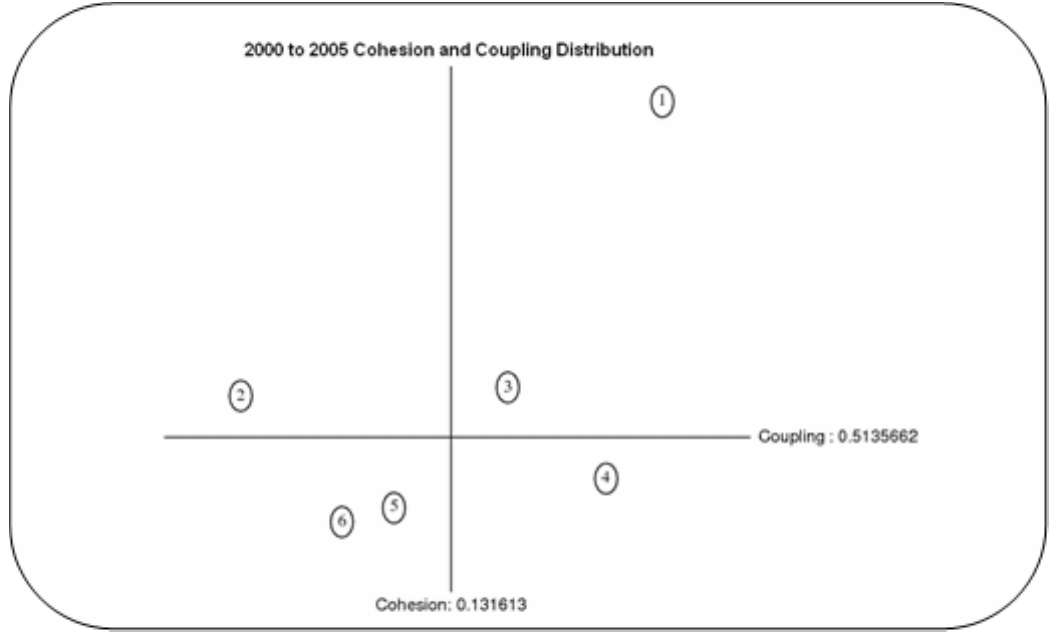
Figure 7 . Cohesion and coupling graph (2000 to